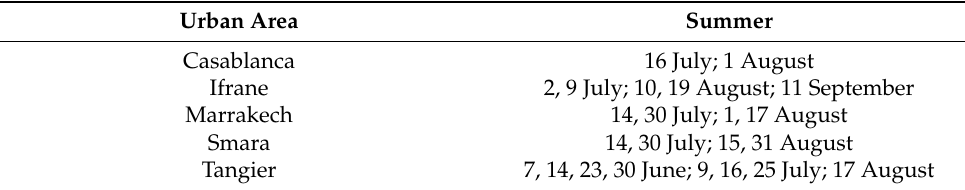
Figure 1. Urban heat island study areas. ( a – e ) Five cities in different climate zones of Morocco shown as 2016 Landsat 8 OLI false-color infrared images (bands 5,4,3) to distinguish built-up from vegetated areas. The scale bar is associated with ( a – e ), all of which are displayed in relative sizes. Table 1. Landsat 8, cloud free, surface temperature product scenes-dates averaged for summer 2016. The local observation time for all scenes was ~12:00